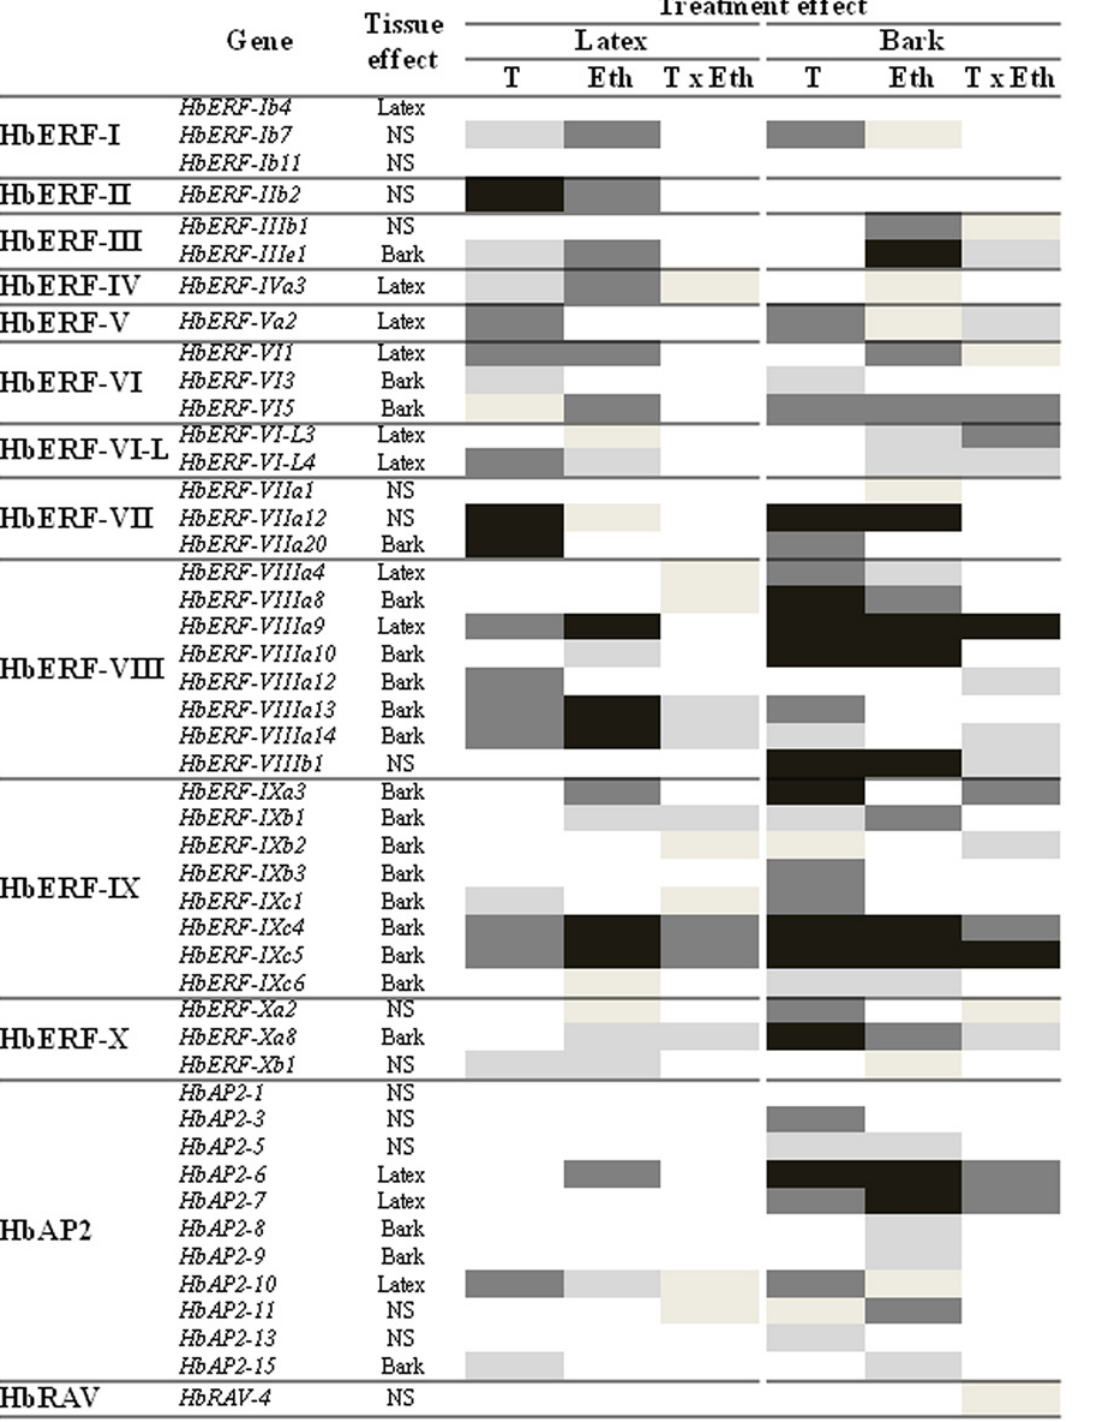
PLOS ONE | DOI:10.1371/journal.pone.0123618 April 23,